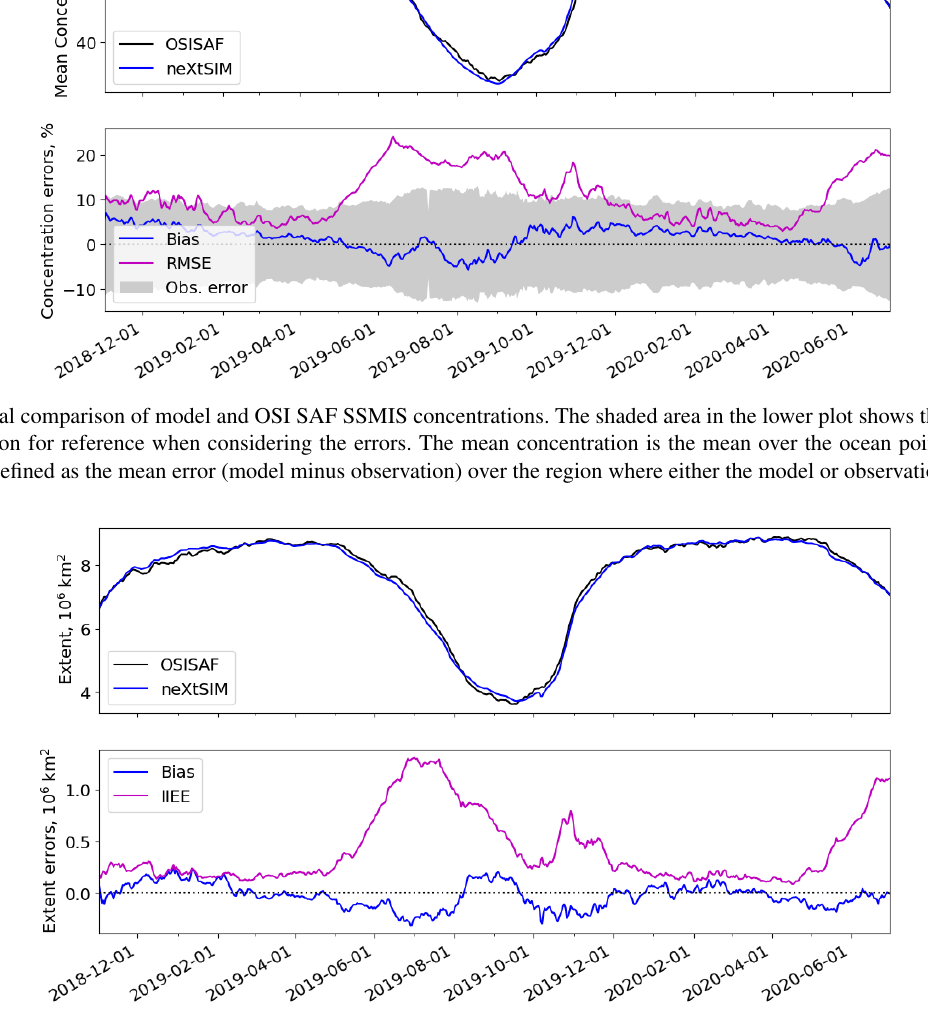
Figure 3. Temporal comparison of extents (region where the concentration exceeds 15%) from model and OSI SAF SSMIS concentrations. The bias is defined as modelled extent–observed